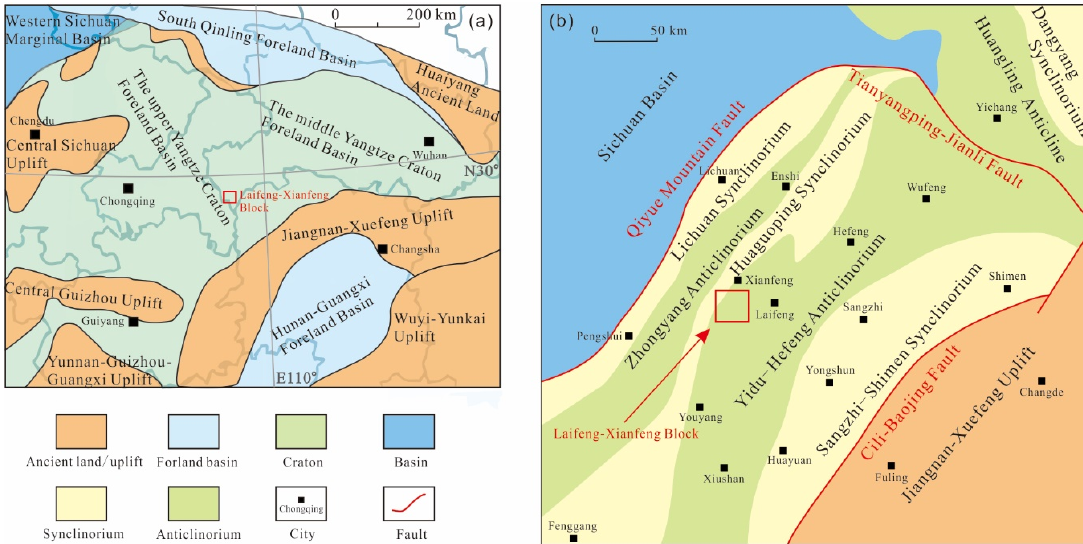
Figure 1. The geologic aspects around the research area. ( a ) Palaeogeographic pattern around the Laifeng–Xianfeng Block in the Sinian-Lower Paleozoic system (modified after [51]). ( b ) Regional tectonic pattern around the Laifeng–Xianfeng Block (modified after [49]).